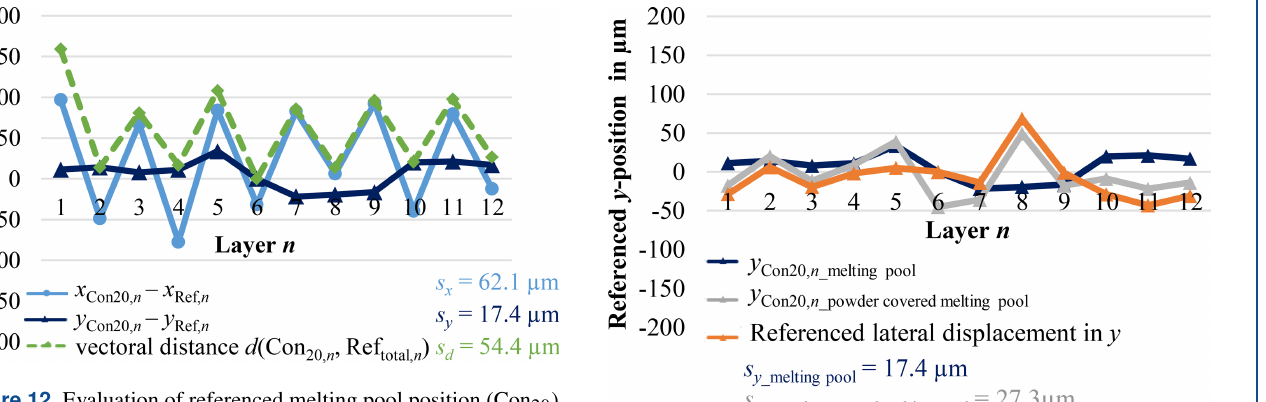
Figure 12. Evaluation of referenced melting pool position (Con 20 ) after the energy input of the laser.